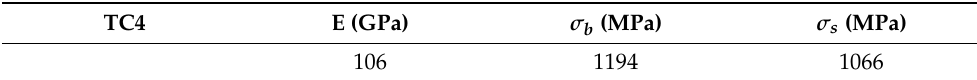
Figure 3. Shape and size of tensile specimen. Table 2. Tensile mechanical properties of bulk